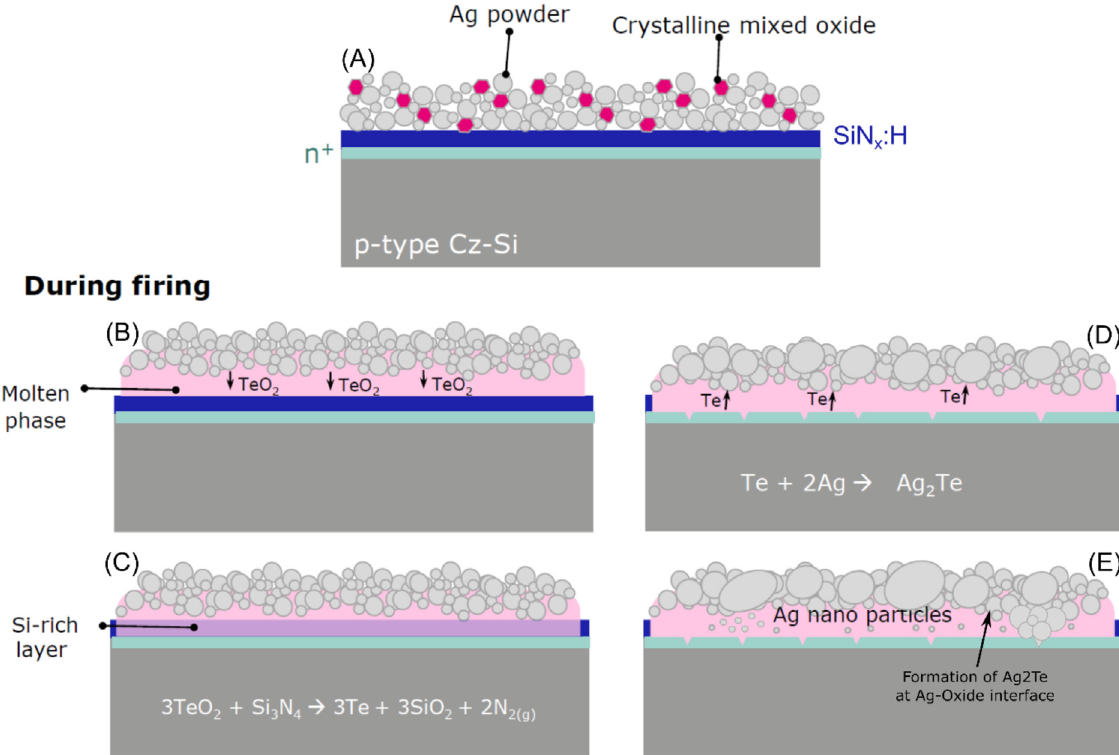
Fig. 10. Schematic model of contact formation with a PbO-free paste based on TeO 2 on an n + -doped Si substrate. For detailed description, see text in Section